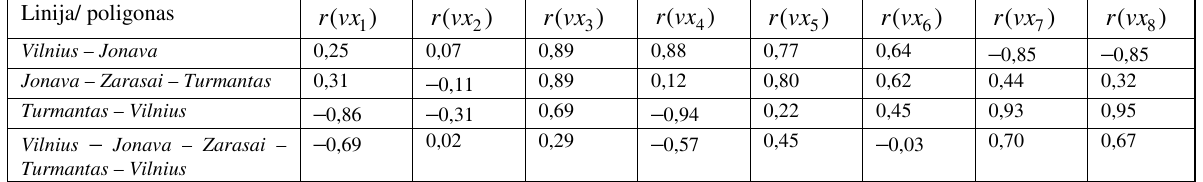
Table 1. The correlation of the vertical Earth’s surface movements with the geological rates Linija/